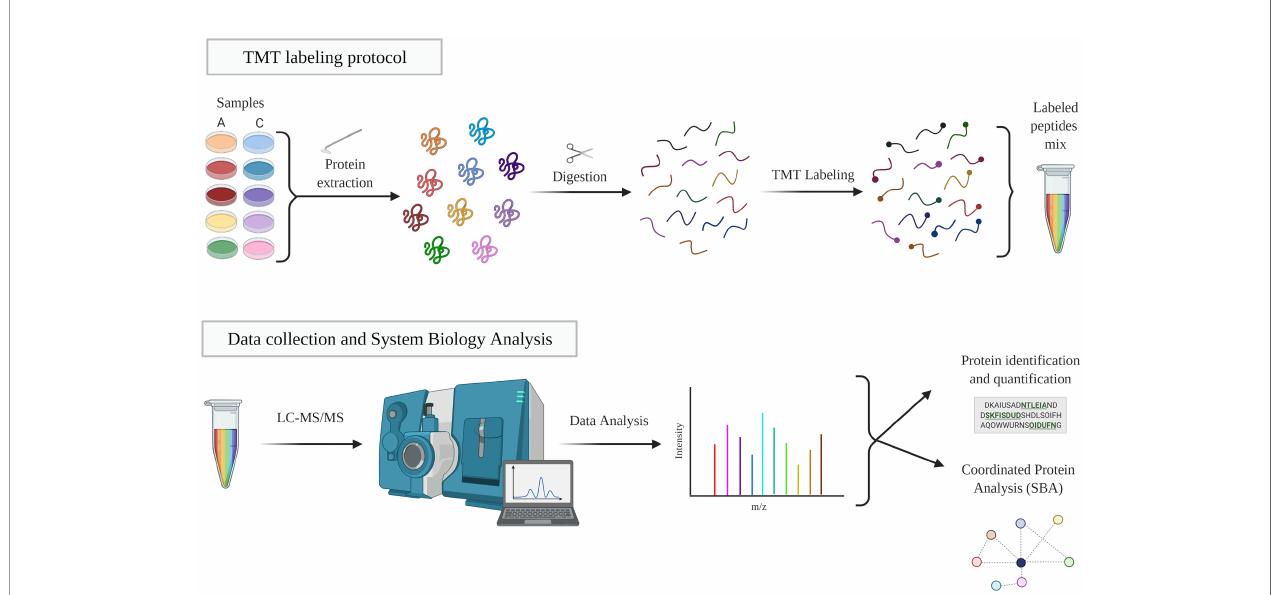
FIGURE 2 | TMT work fl ow. Protein extracts were digested, labeled and analyzed by LC-MS/MS. The resulting proteins were identi fi ed and quanti fi ed and then studied individually and collectively studied. A, EC-anaphylaxis; C, EC-control; LC-MS/MS, liquid chromatography-mass